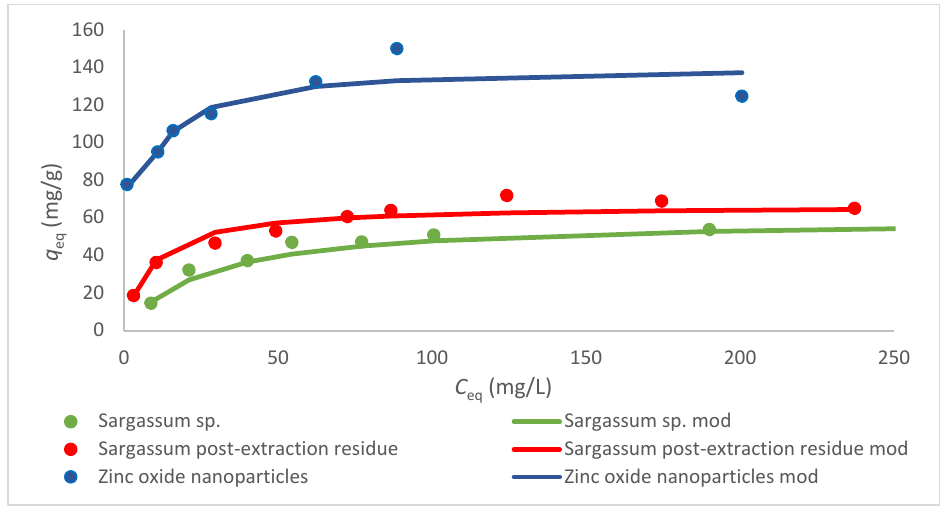
Figure 7. Langmuir isotherms for different sorbents ( C 0 25–300 mg/L, C S 1.0 g/L, and pH 5). From all the sorbents examined in this study, the highest value of q max was obtained for ZnO NPs (120 mg/g), then for the Sargassum sp. post-extraction residue, and finally for Sargassum sp. These results coincide with the outcomes obtained for the kinetics of the sorption process. A comparison of the maximum sorption capacities of the tested sorbents towards Cr(III) ions with the results obtained by different researchers is difficult because the process is usually performed under different experimental conditions (Table 7). Table 7. Comparison of the values of maximum sorption capacities determined on the basis of equilibrium sorption models depending on the sorption conditions, metal ion, and sorbent used. Sorbent Metal Ion Sorption Conditions q max Reference